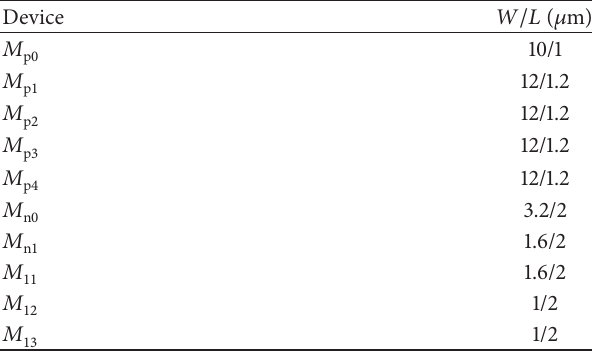
Table 1: The 𝑊/𝐿 values of the CMOS in Figure 3.